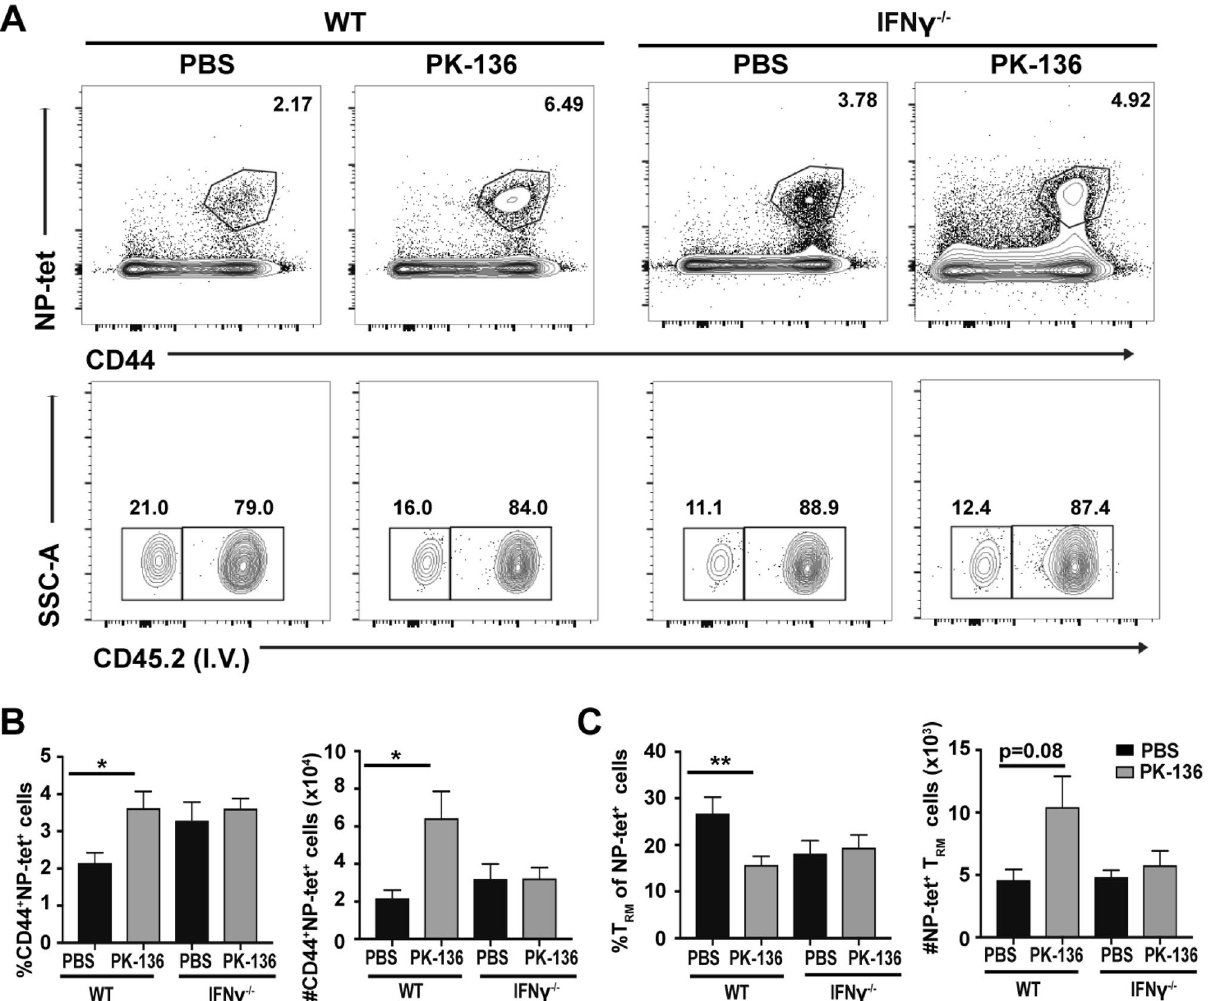
Figure 7. Enhanced respiratory T RM development in NK-deficient mice is independent of IFN-γ. ( A ) C57/ BL6 WT and IFN-γ −/− mice were administered 200ug of PK136 or 200ul PBS 1 day prior to infection with 10 3 pfu x31. Mice were sacrificed 35 days later and frequency of CD8 + CD44 + NP-tet + cells, as well as NP-tet + T RM cells (identified by lack of staining with an anti-CD45 antibody administered i.v. 3 min prior to euthanasia) in the lung assessed. Frequency and total number ± SEM of ( B ) CD8 + CD44 + NP-tet + cells and ( C ) NP-tet + T RM cells in the lung 35 days post infection in WT or IFN-γ −/− NK-depleted (grey bar) and PBS treated (black bar) mice. Graphs are representative of pooled data from 2 independent experiments using n ≥ 3 mice/group (total WT/ PBS: n = 7, WT/NKdep: n = 11, IFN-γ −/− /PBS: n = 6, IFN-γ −/− /PK-136: n = 8 depicted). *p < 0.05, **p < 0.01; One- way ANOVA with multiple comparisons